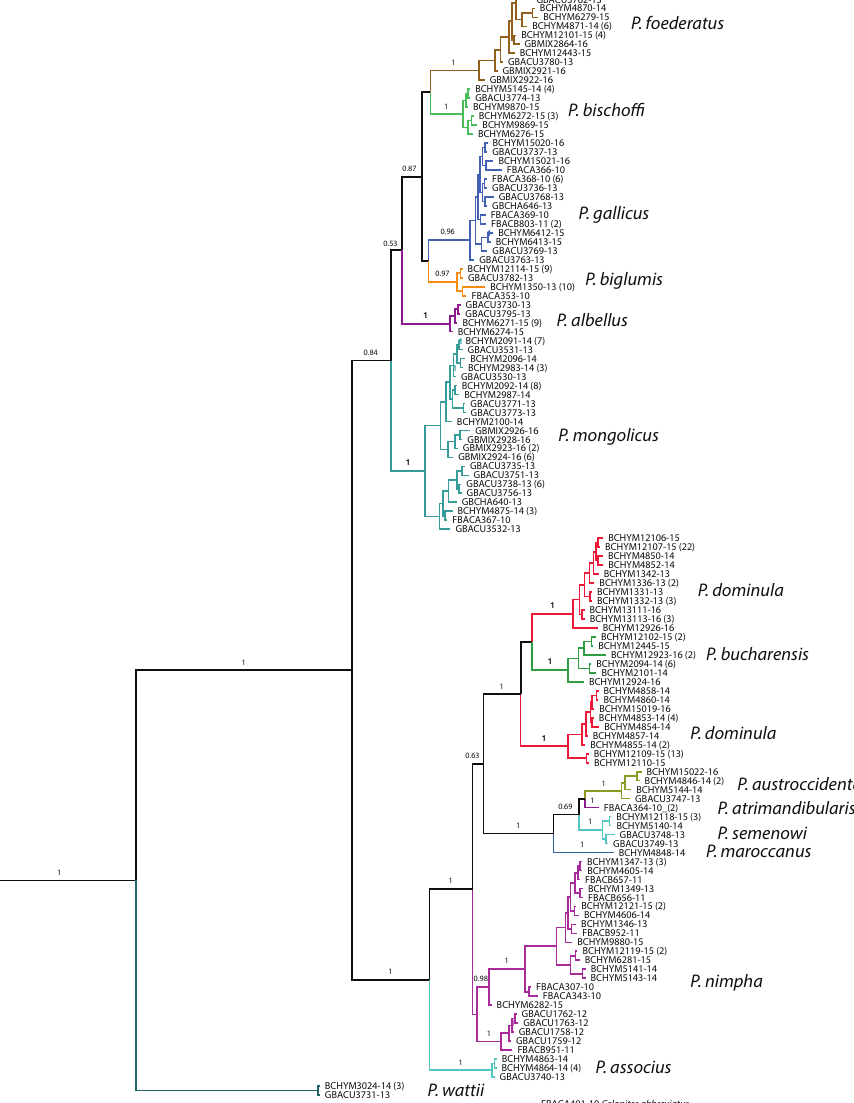
Figure 58. Phylogenetic tree resulting from Bayesian analysis of COI sequence data. Number in brackets after terminal branch labels (Process ID) indicate number of haplotype sequences. Numbers on branches denote posterior probability values (omitted for branches within